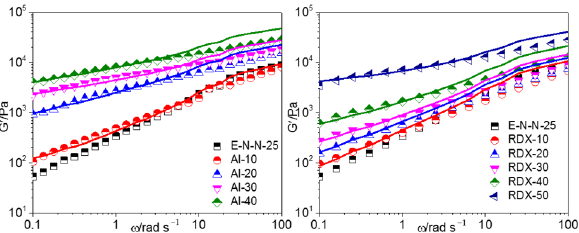
Figure 12. Measured values in dot and two-phase model simulation values in solid line under the curve G ′ - ω of model propellant at 130 °C.